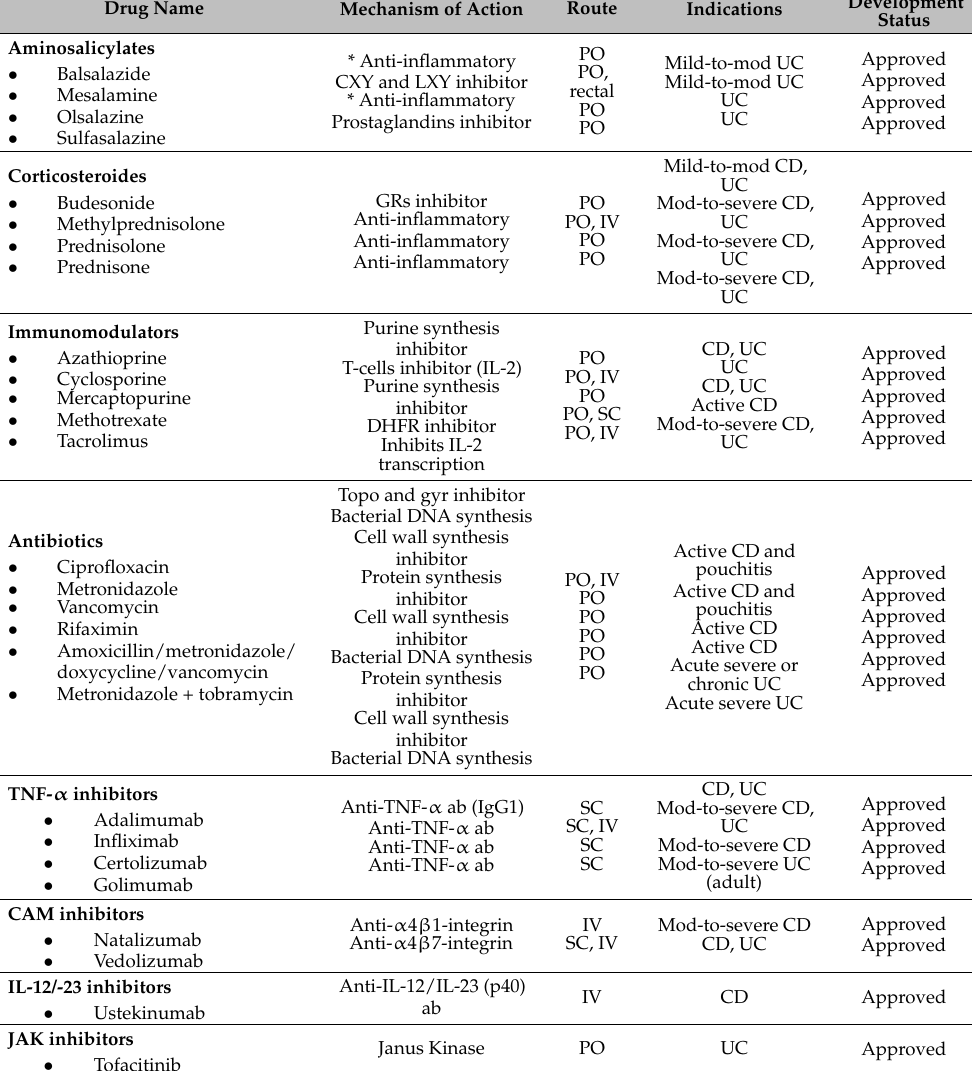
Table 2. Therapeutic options for UC and